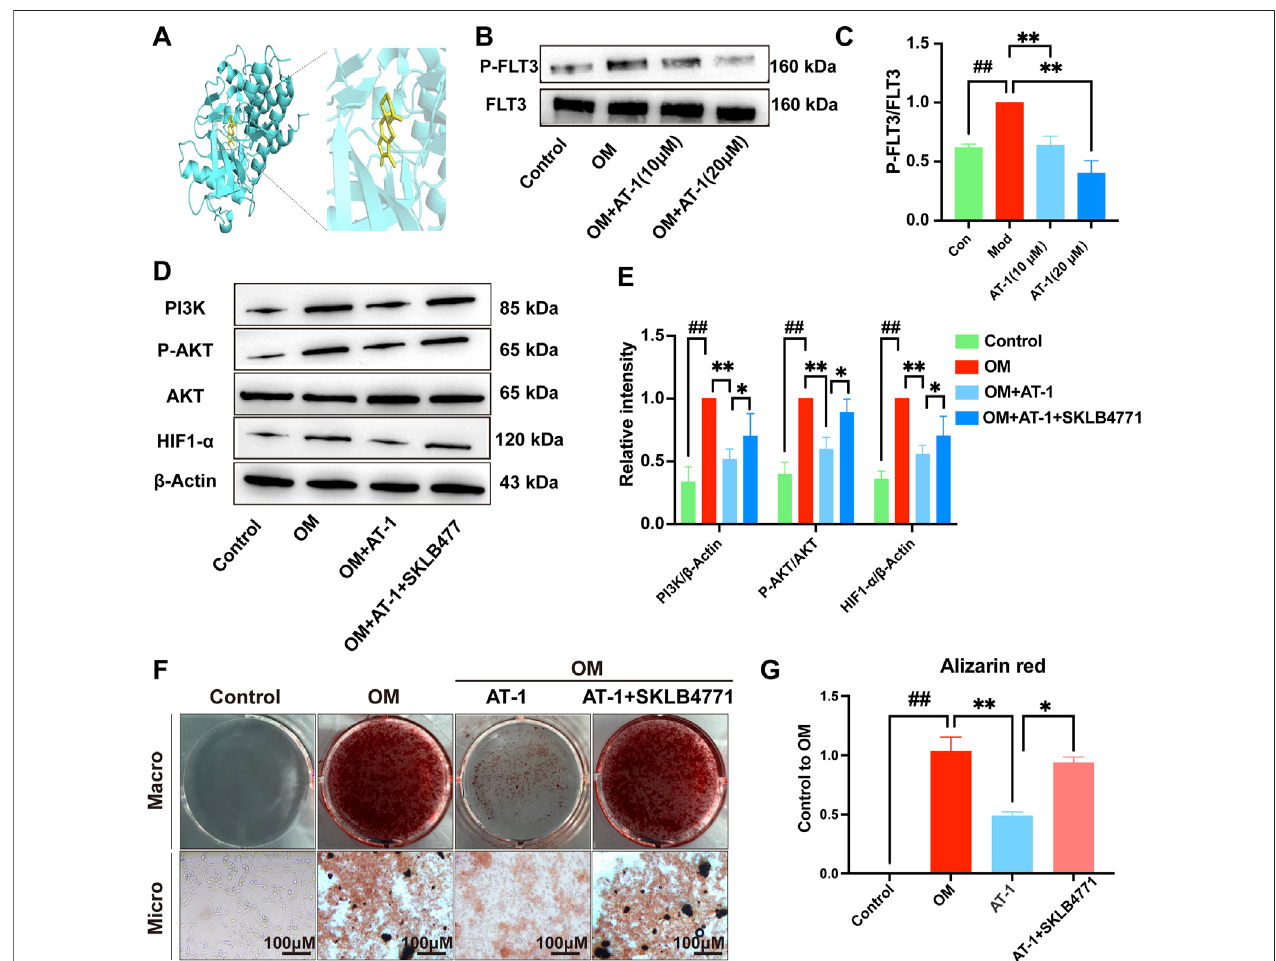
FIGURE5| AT-1inhibitsthephosphorylationofFLT3andtheactivationofPI3K/AKT/HIF1- α ,therebyinhibitingtheosteogenicdifferentiationofVICs. (A) Molecular dockingtechnologywasusedtodetectthebindingabilityofAT-1toFLT3protein. (B) EffectofdifferentAT-1concentrationsonthelevelofphosphorylatedFLT3protein in OM-induced VIC cells. (C) StatisticalanalysisofP-FLT3/FLT3. (D) Effect ofAT-1 treatmentwith or withoutFLT3 inhibitoron theregulationofPI3K/AKT/HIF1- α in OM- induced VICs. (E) Statistical analysis of PI3K/ β -actin, P-AKT/AKT, and HIF1- α / β -actin. (F) Cells with different treatments (control, OM, OM+20 μ M AT-1, and OM+20 μ M AT-1+10 nM SKLB4771) were stained with Alizarin Red S. (G) Alizarin Red staining statistics. * p < 0.05, ** p < 0.01 indicated a signi fi cant difference compared to the control group and # p < 0.05, ## p < 0.01 indicated a signi fi cant difference compared to the OM group, n = 3.